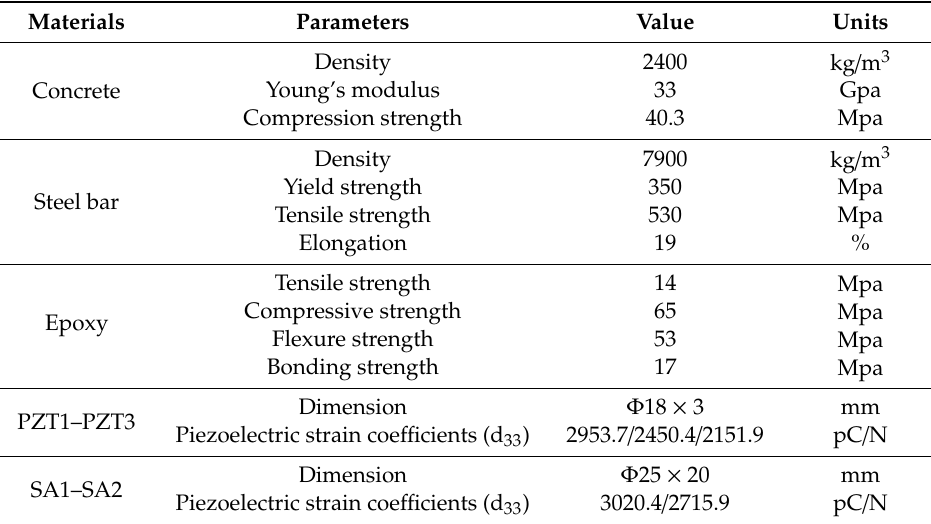
Table 1. The material properties of the test